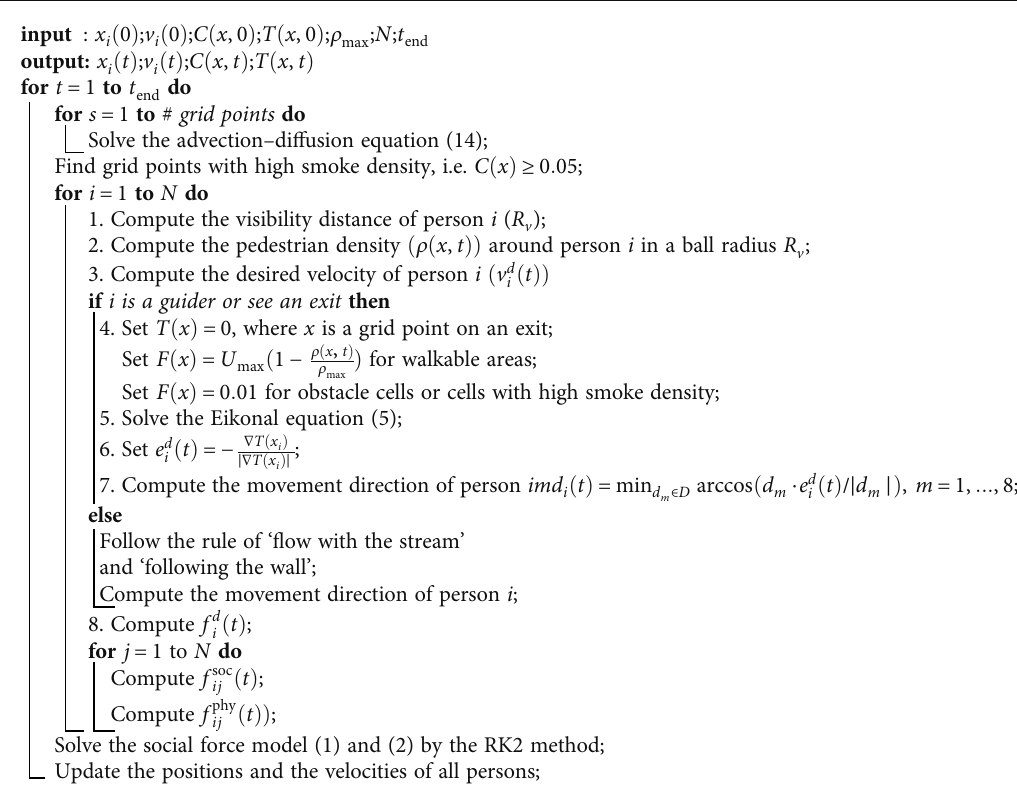
Algorithm 1: Main update